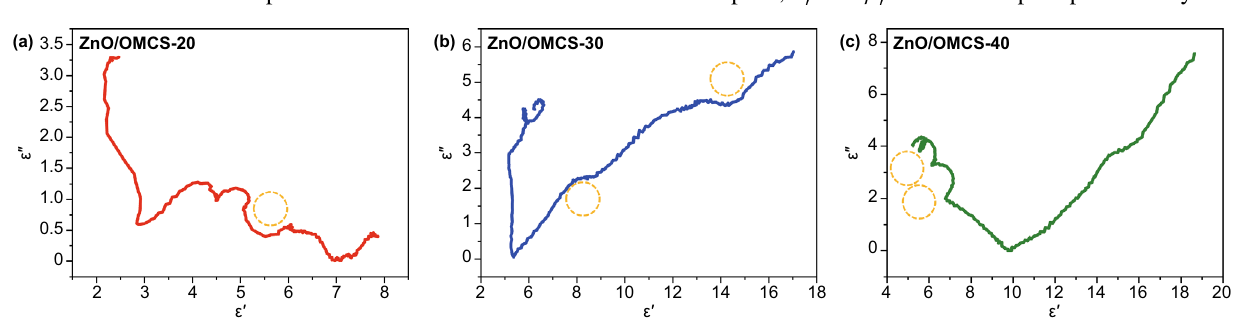
Fig. 6 Typical Cole–Cole semicircles ( ε ′ vs. ε ′′ ) for a ZnO/OMCS-20, b ZnO/OMCS-30, c